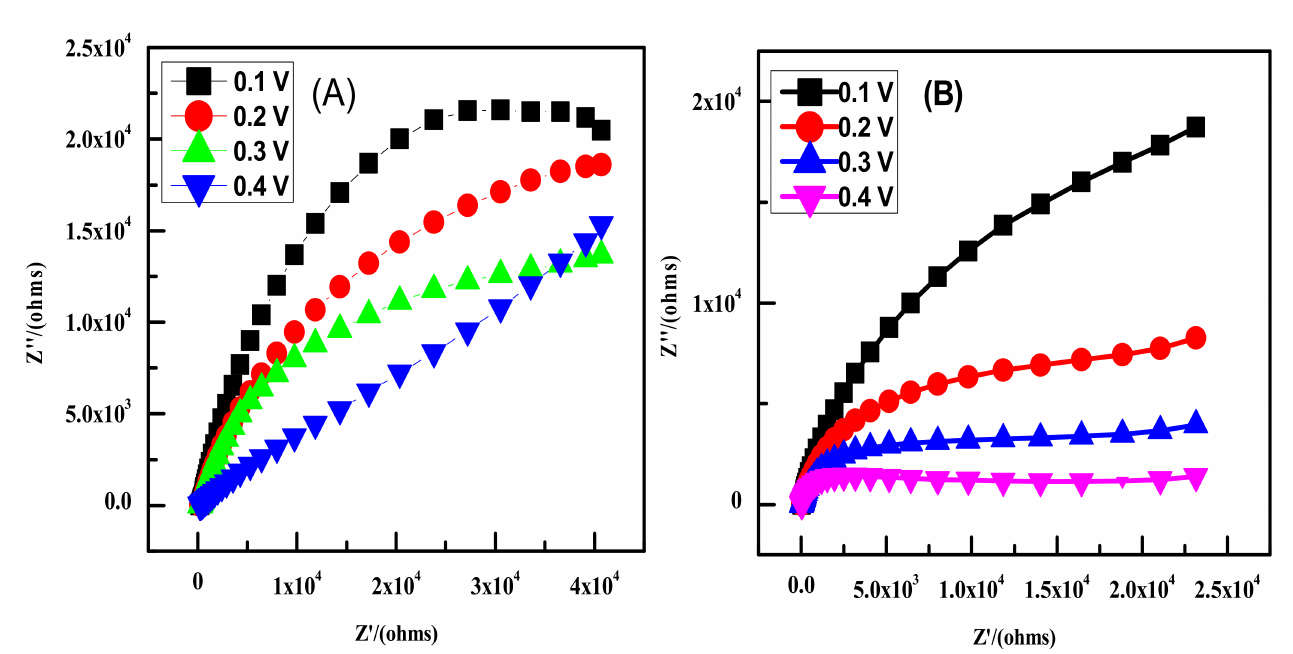
Figure 10. Nyquist plots measured at different potentials as indicated in ( A ) 0.06 M NaOH + 5 M CH 3 OH and ( B ) in 1.8 M NaOH + 5 M CH 3 OH